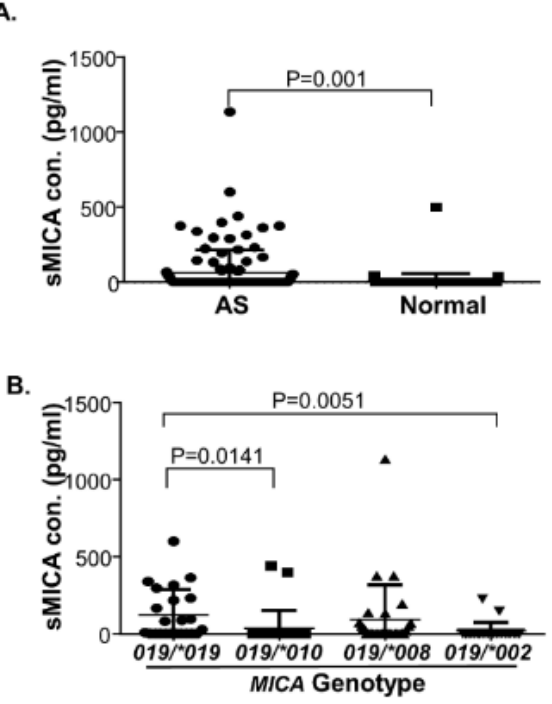
Figure 1. Elevated levels of soluble MICA (sMICA) in AS patients and MICA*019 homozygous genotype subjects. ( A ) Serum sMICA levels in AS patients and normal healthy controls. The serum sMICA levels were significantly increased in AS patients (N = 112, sMICA concentration: 63.35 ± 14.65 pg/mL), as compared to normal healthy controls (N = 92, sMICA concentration: 6.224 ± 5.417 pg/mL) ( p = 0.001). ( B ) Serum sMICA levels in AS patients carrying MICA*019 al- lele. MICA*019/*019 subjects produced significantly more sMICA (N = 23, sMICA concentration: 122.8 ± 34.39 pg/mL) than MICA*019/*010 (N = 30, sMICA concentration: 27.88 ± 19.40) ( p = 0.0141) and MICA*019/*002 (N = 23, sMICA concentration: 16.10 ± 11.39) ( p = 0.0051) subjects. MICA*019/*019 subjects produced higher levels of sMICA (N = 23, sMICA concentration: 122.8 ± 34.39 pg/mL) than MICA*019/*008 subjects (N = 29, sMICA concentration: 90.95 ± 41.76 pg/mL), but the difference was statistically